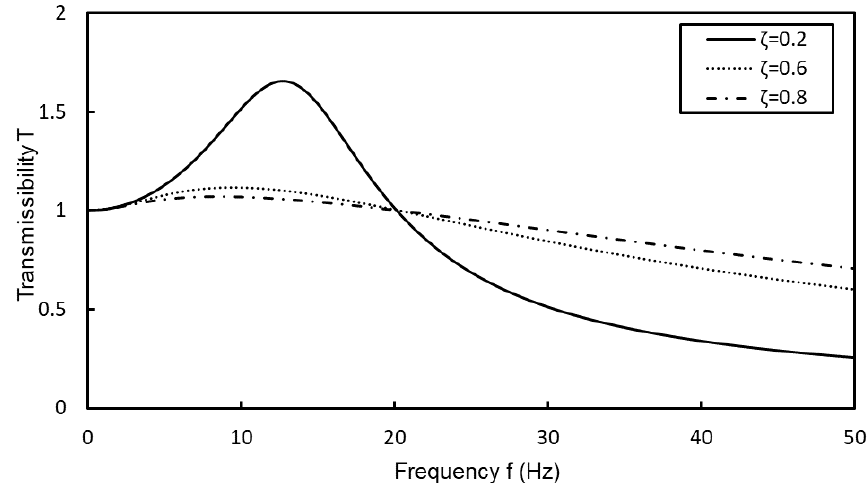
Figure 13. Transmissibility of the hydraulic viscous damper module of VEAM with varying values of ζ .